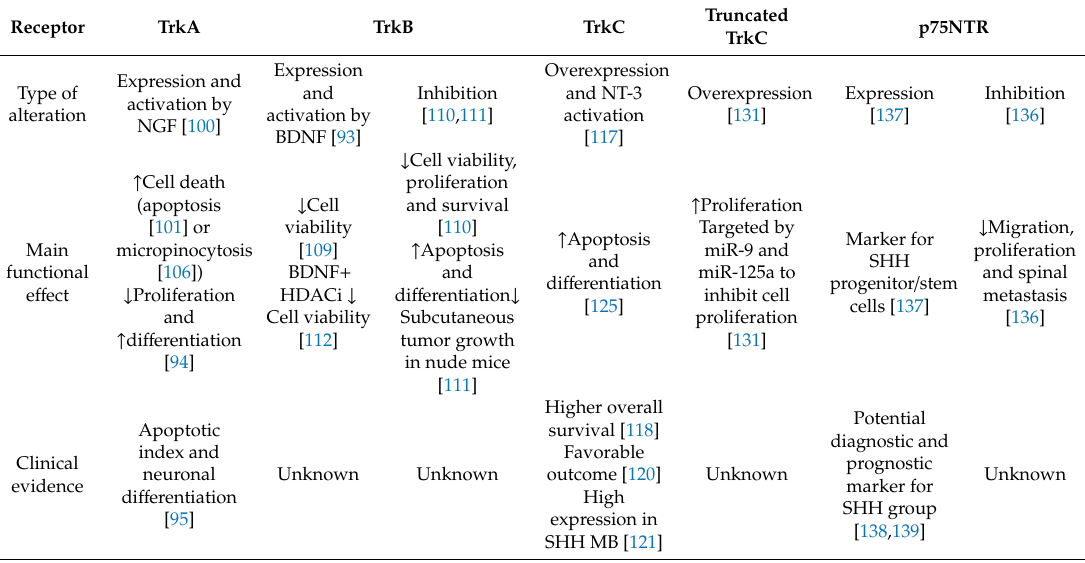
Table 1. Summary of studies examining the involvement of neurotrophin receptors in